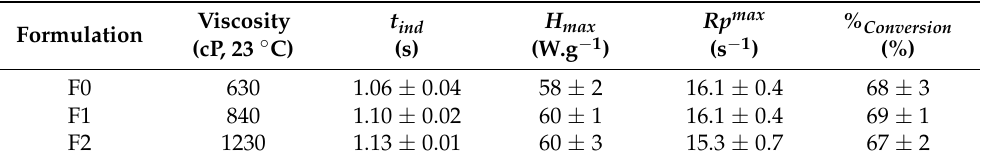
Figure 2. Polymerisation rate of the different coatings. Table 2. Coating viscosity and photo-DSC results including the induction time, the maximum heat flow, the rate of polymerisation and the unsaturation conversion.